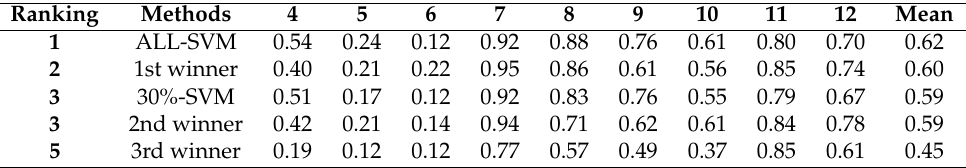
Table 5. Maximum Kappa value of the proposed combined feature vectors (100% and 30% of training data), and winning methods of the dataset